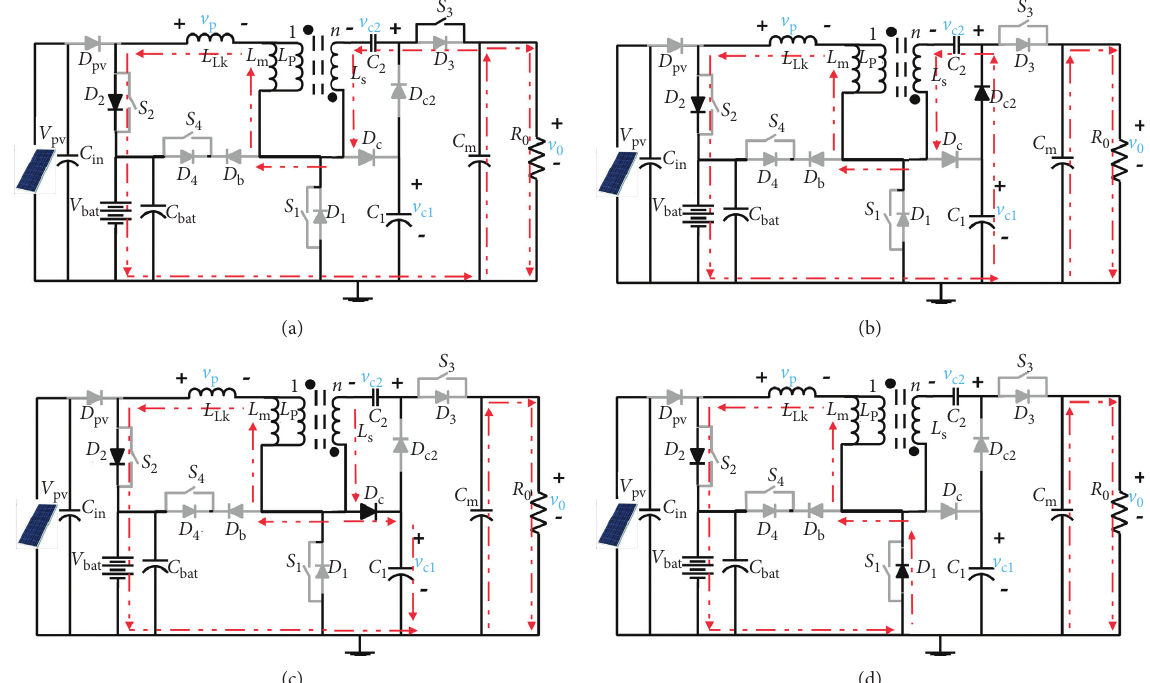
Figure 4: Steady-state equivalent circuits and current flow of the converter in SISO mode (buck operation). (a) t ∼ t (d) t 4 5